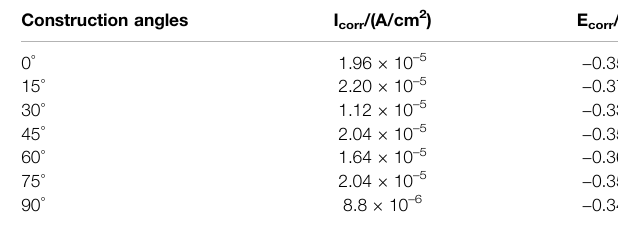
TABLE 2 | Potentiodynamic polarization results of SLM-formed 316L